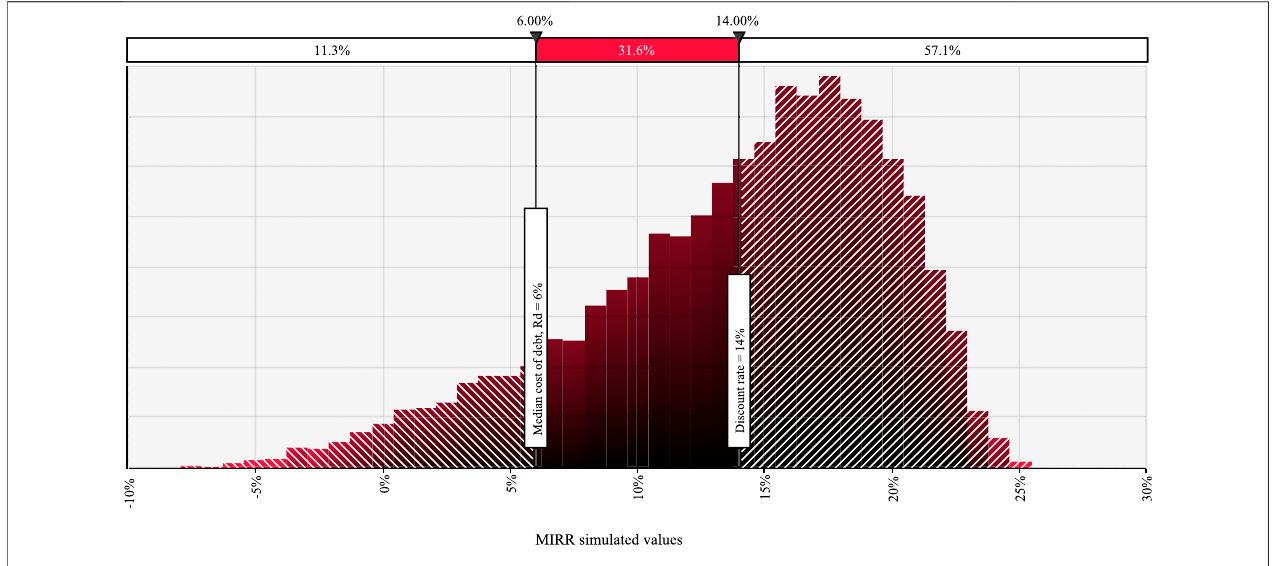
Frontiers in Energy Research |